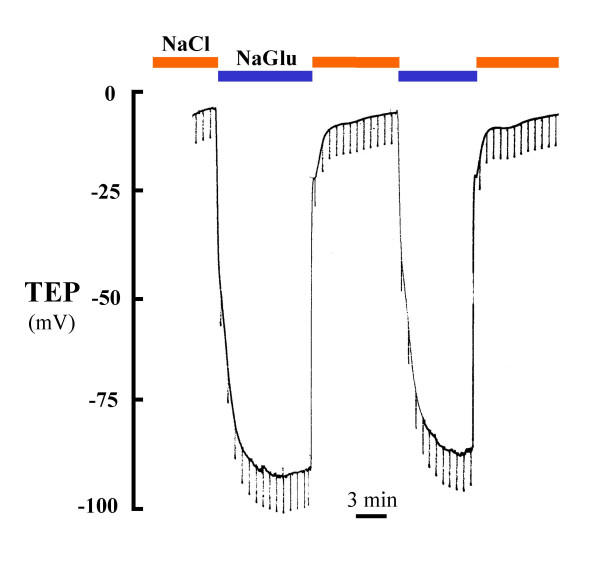
Effect of luminal Cl- substitution in a perfused small bronchiole on TEP. The substitution of Gluconate, an impermeant anion, for permeable Cl- in the lumen markedly hyperpolarized the TEP. This response indicates a predominant Cl- conductance that appears to be constitutively active.